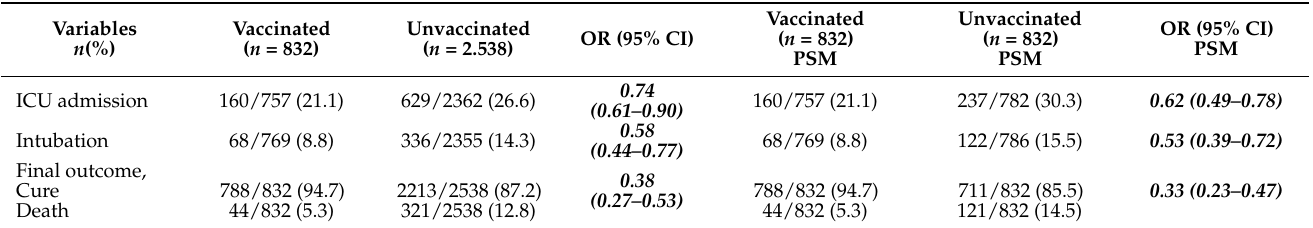
Table 3. Characteristics of COVID-19 outcomes according to vaccination status—overall and after propensity score